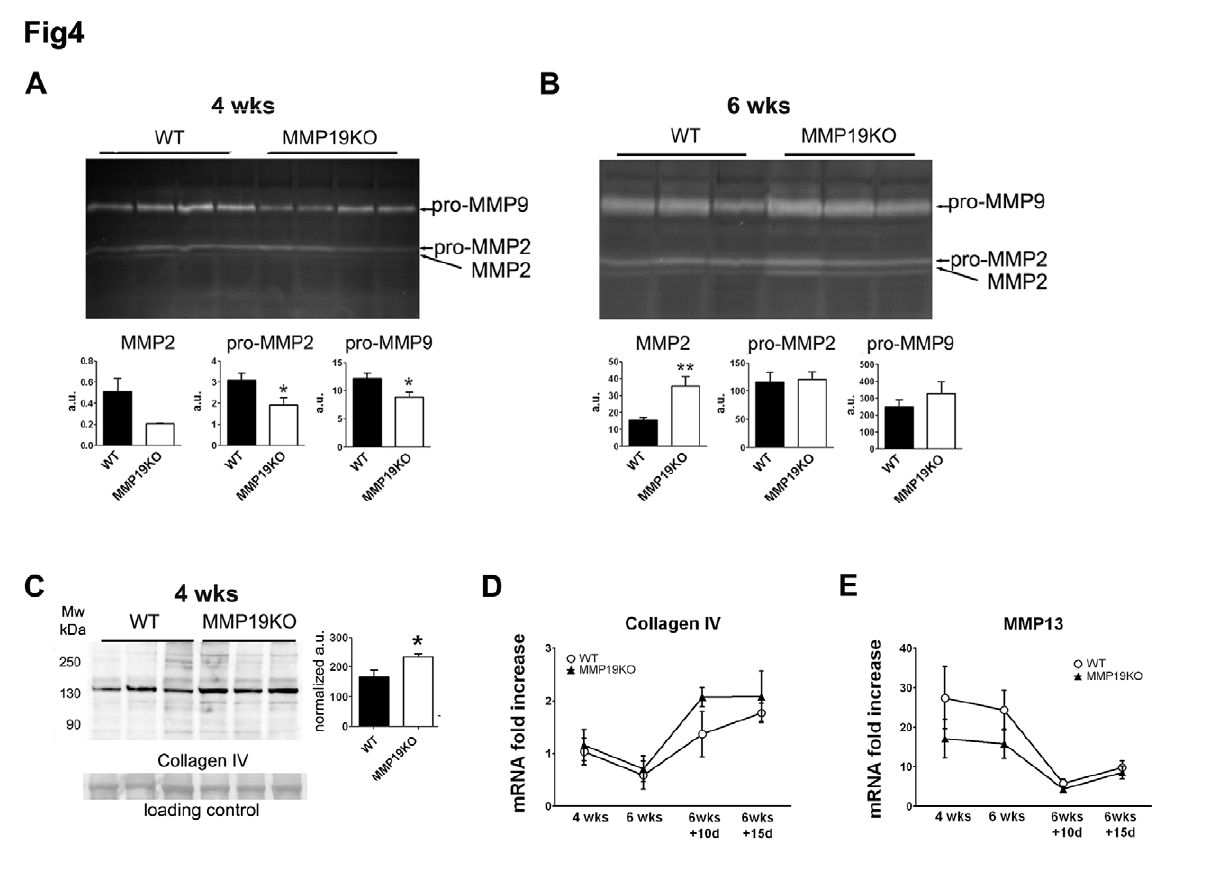
Figure 4. MMPs expression and processing during liver damage progression. (A, B) MMP-2 and MMP-9 expression and activity in liver lysates was analyzed using gelatin zymography. (A) At 4 weeks, WT livers showed higher MMP2 processing and pro-MMP-2 and pro-MMP-9 expression. n=4 for each strain. (B) At 6 weeks, levels of activated MMP-2 were significantly increased in MMP19KO liver and pro-MMP2 and -MMP9 expression was comparable in WTs and MMP19KOs. n=6 for each strain. (C) Western blot analysis showed increased collagen IV expression in MMP19KO liver at 4 weeks of CCl 4 . As loading control, the membrane was stained with Ponceau S. n=10 for each strain. (D) mRNA analysis showed slightly higher collagen IV expression in MMP19 KO than in WT mice. n=5 animals of each strain analyzed at each time point. (E) qRT-PCR analysis showed slightly reduced expression of MMP13 mRNA levels in MMP19KO mice; 4–9 mice of each strain were analyzed at each time point. *p , 0.05, **p , 0.01 MMP19KOs vs.